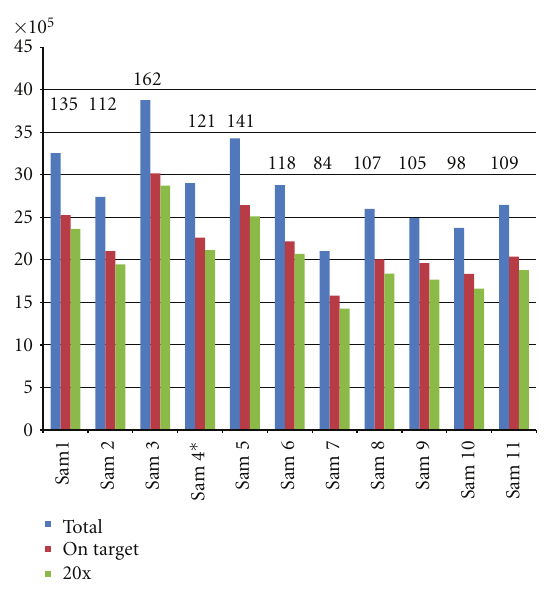
Figure 1: Specifications of 11 DNA libraries pooled and sequenced on one flow cell lane of an Illumina GAIIx. Numbers on top of the bars indicate the average sequencing depth obtained for the individual samples. Blue bars indicate total number of unique reads, red bars indicate reads that fall on target of the bait design, green bars indicate reads that fall in target regions covered with at least 20x depth. Sample 4 is a mix of genomic DNA from two individuals 4a and